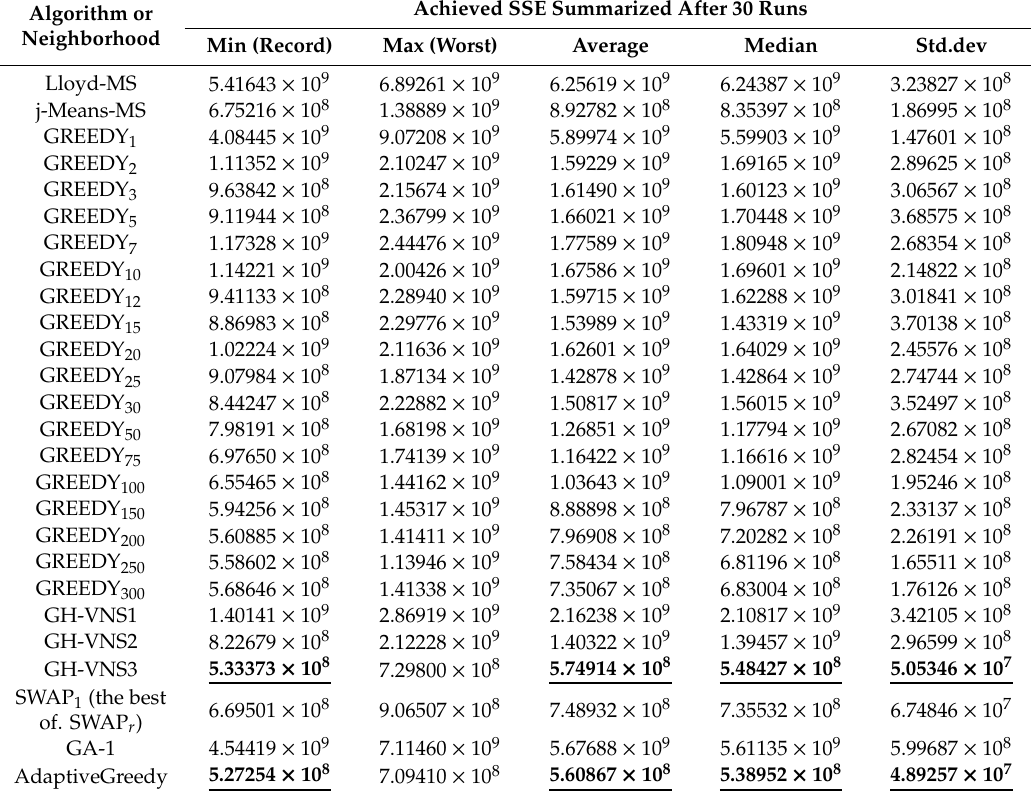
Table A5. Comparative results for Mopsi- Finland data set. 13,467 data vectors in R 2 , k = 300 clusters, time limitation 5 s.